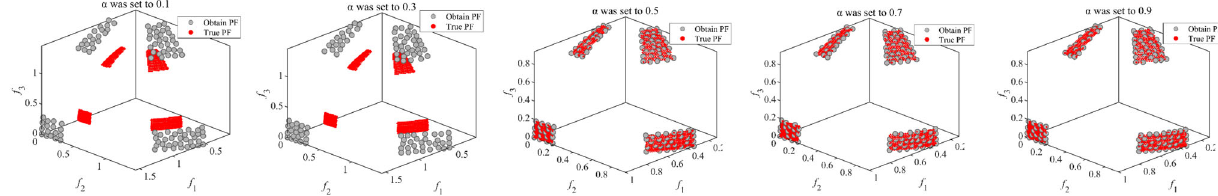
Fig. 9 Pareto fronts with median IGD value among 30 runs obtained by EGDCMO on DC3-DTLZ3 corresponding to different values of